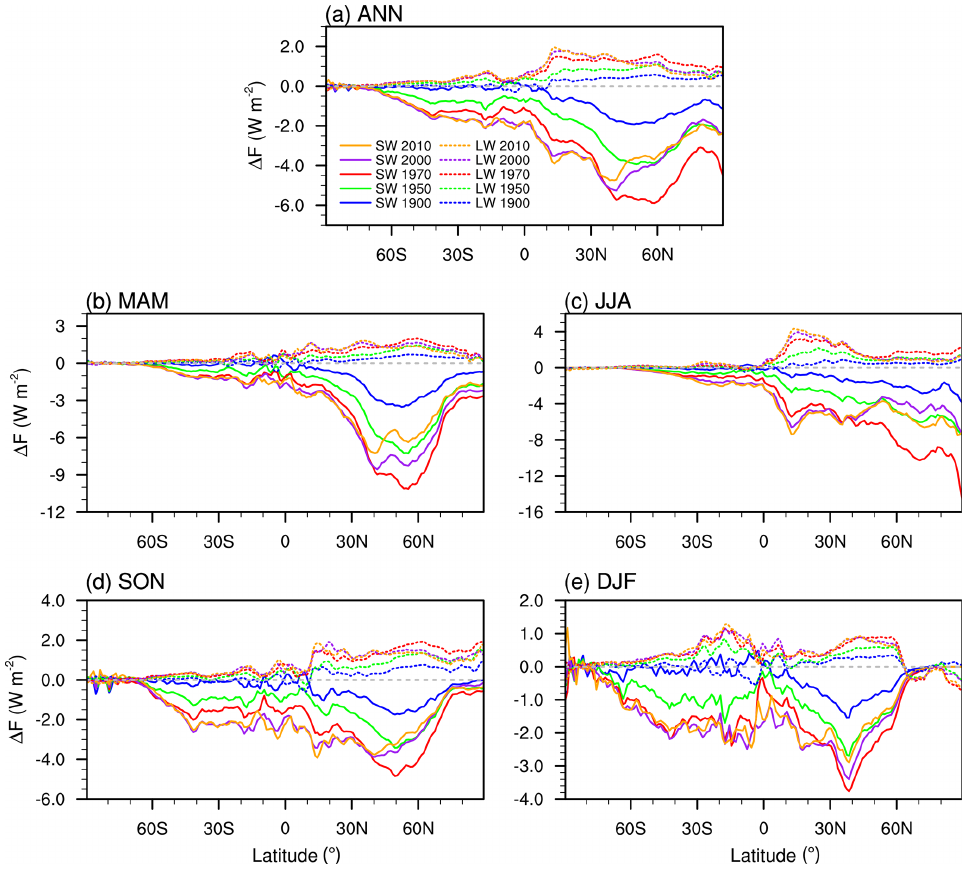
Figure 6. Annually and seasonally averaged zonal mean top-of-model (cid:49) F (Wm − 2 ) estimated for different time slices (emission years) indicated by different colors. Solid lines show the shortwave (cid:49) F and dotted lines the longwave (cid:49) F. In JJA, the shortwave (cid:49) F for 1970 (relative to 1850) is about − 14Wm − 2 near the North Pole. See Sect. 3.2 for